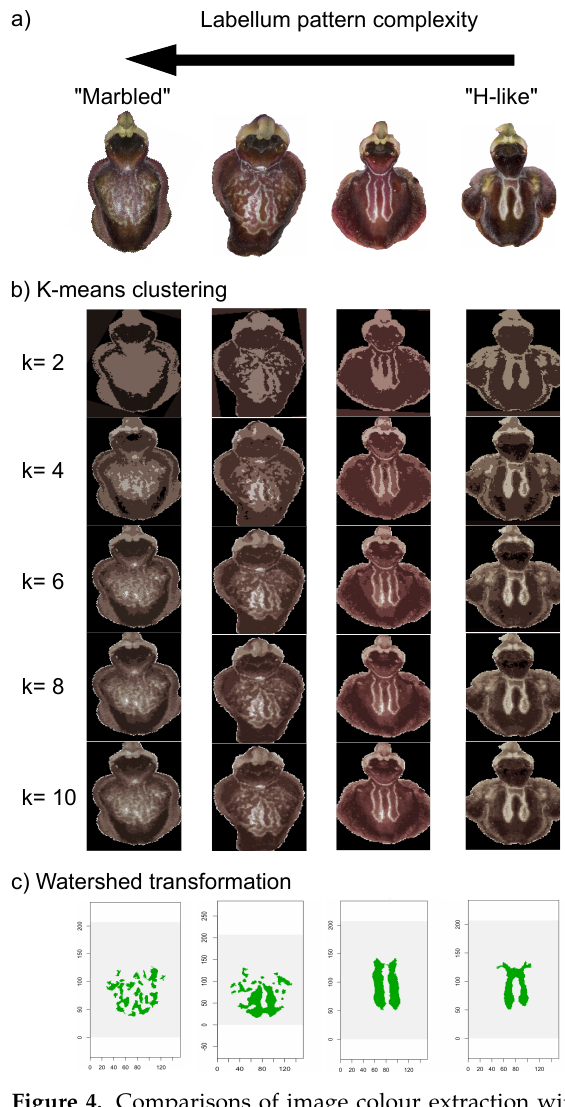
Figure 4. Comparisons of image colour extraction with patternize using k -means clustering and watershed transformation for four specimens of Ophrys aveyronensis . ( a ) Labellum image. Specimens exhibited a gradient of complexity from “H-like” to a “marbled” pattern on their labellum. ( b ) k - means clustering with k = 2, 4, 6, 8, and 10. ( c ) Watershed